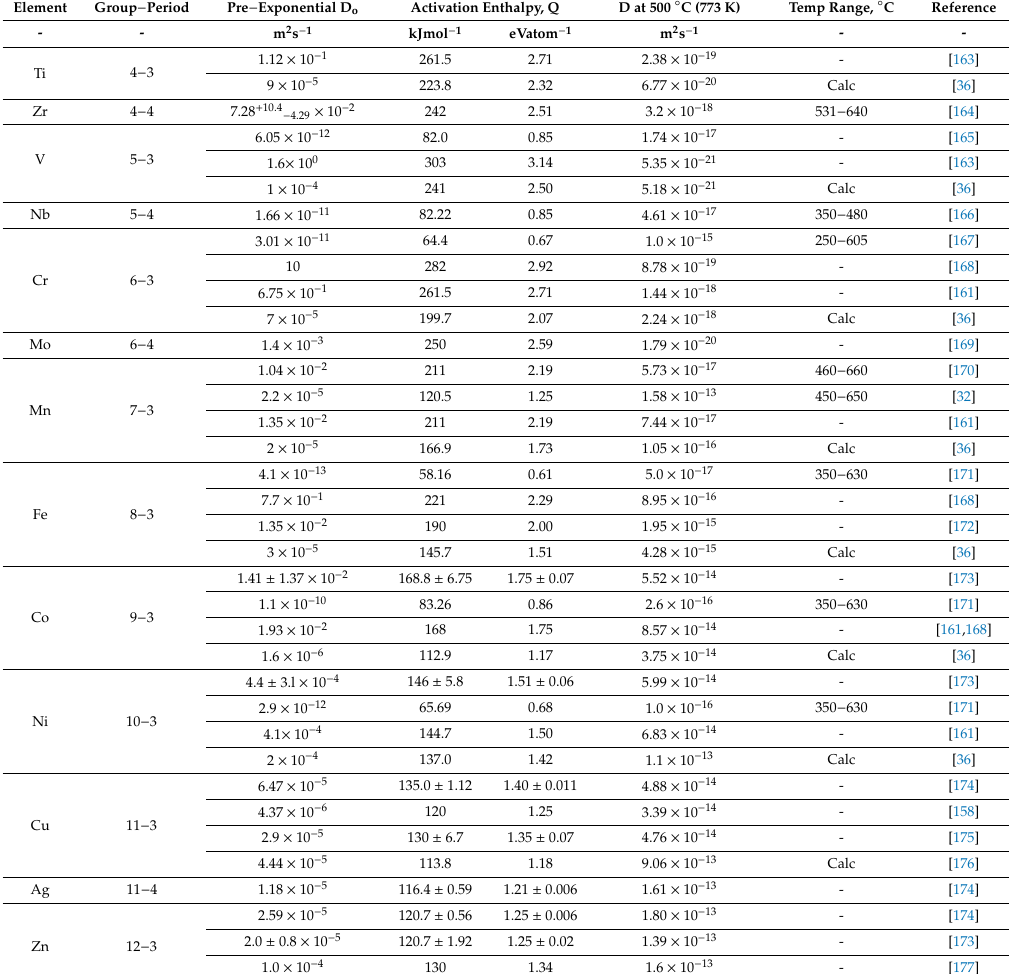
Table A2. Measured di ff usivities for transition elements in aluminum (data calculated are indicated). Element Group − Period Pre − ExponentialD o ActivationEnthalpy,Q Dat500 ◦